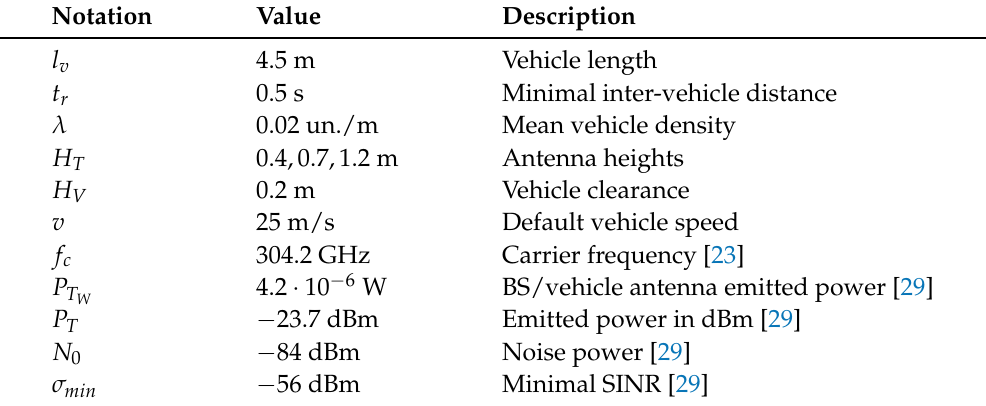
Table 3. The default system